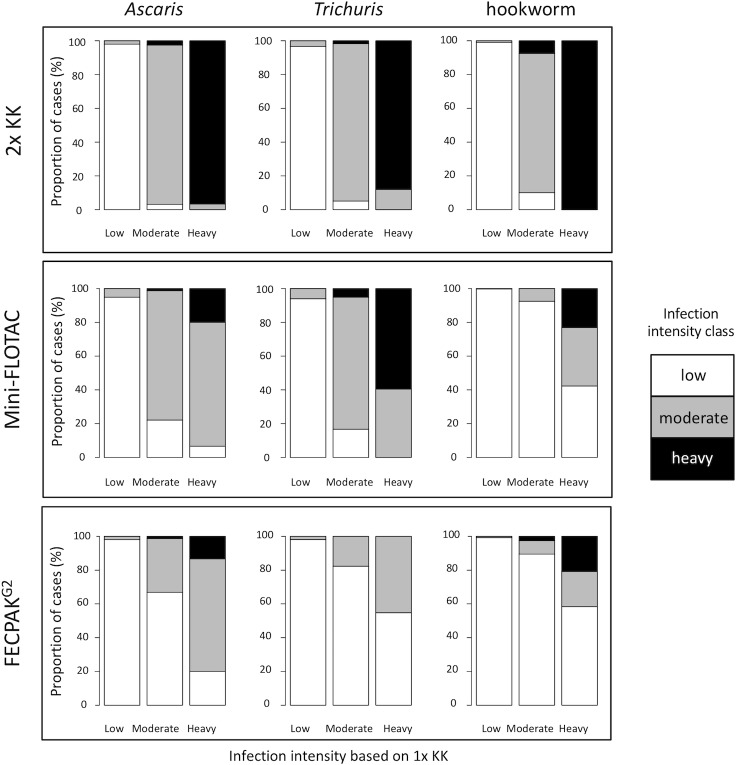
Agreement in infection intensity classification by four microscopic method.Each bar represents all cases classified by a single Kato-Katz (1x KK; reference method) into low, moderate or heavy infection intensity using the WHO threshold criteria (Table 2). The Y-axis of each bar represents the proportion of these cases that are categorized as low, moderate and heavy intensity infections by means of a duplicate Kato-Katz (2x KK; top row plots), Mini-FLOTAC (middle row plots) and FECPAKG2 (bottom row plots). The white color indicates cases classified as low infection intensity, grey indicates cases classified as moderate infection intensity and black indicates cases categorized as heavy infection intensity, by either duplicate Kato-Katz, Mini-FLOTAC or FECPAKG2. There is a full agreement in classifying the intensity of infection with the reference method when the bars representing low, moderate and high infection intensities by the reference method are completely white, grey and black, respectively. As an example, of all heavy intensity hookworm infections, only approximately 20% are classified correctly as heavy when using the FECPAKG2, and approximately 60% and 20% are misclassified as low and moderate, respectively.